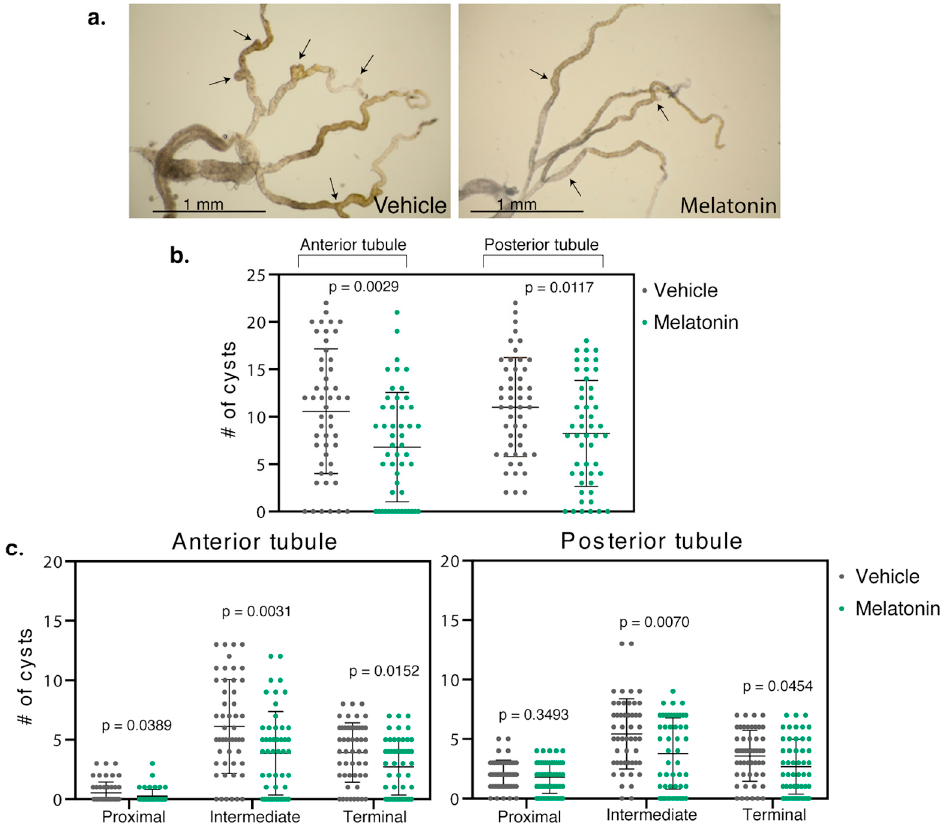
Table 2. Regional cyst reduction upon melatonin treatment of BicC mutants.